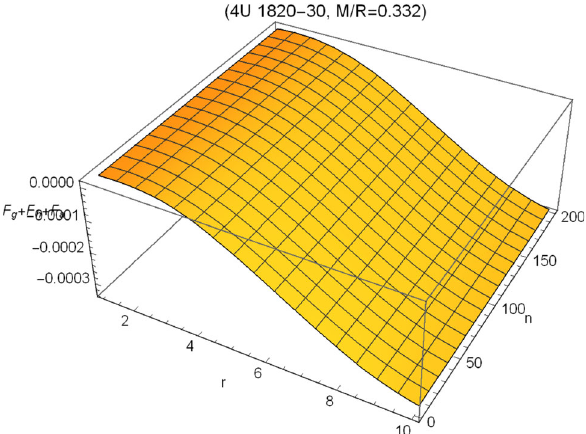
Fig. 10 Plot of TOV equation for compact star candidate